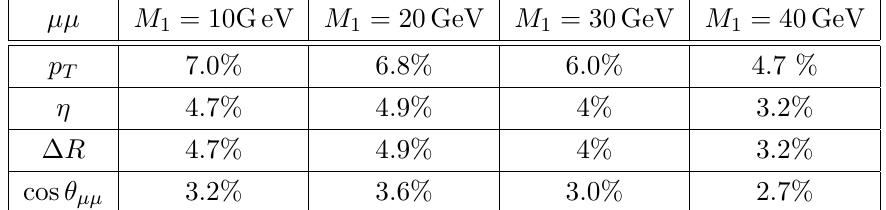
Table 2 . Signal e(cid:14)ciciencies after consecutive cuts on p T , (cid:17) and (cid:1) R for the (cid:22)(cid:22) channel in the muon chamber for various heavy neutrino masses. to the expected exponential distribution. The impact parameter of the lepton in